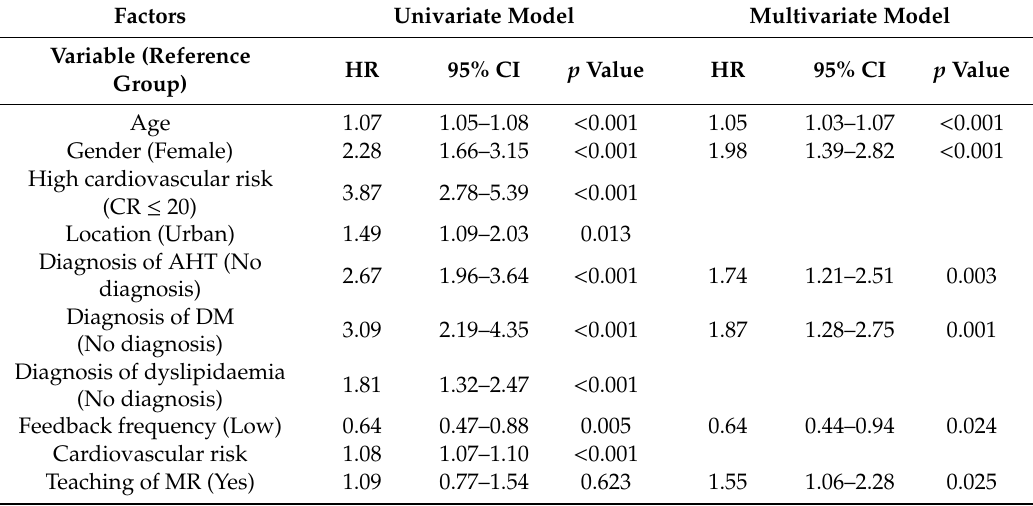
Table 4. Association between cardiovascular disease and sociodemographic characteristics and indicators of health by multiple Cox regression.